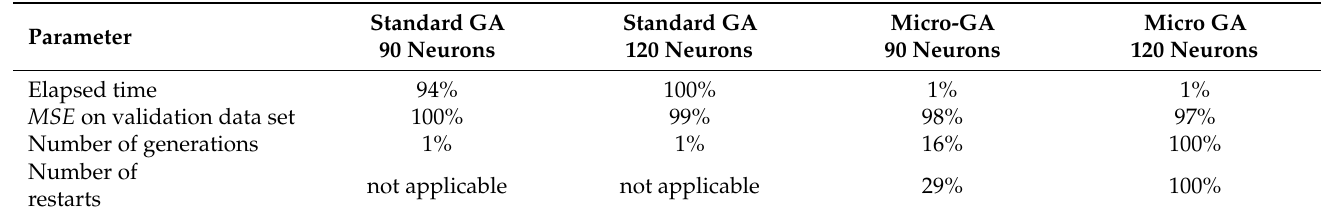
Table 4. The empirical assessment of the two presented GA algorithms. Values are expressed in percentages (see text for